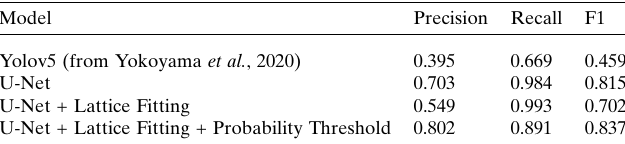
Table 3 Performance metrics of different methods on held-out sessions for hole localization from medium-magnification images. Reported metrics are aggregated by session and averaged. Definitions of true positive, false positive and false negative used for computing precision, recall, and F1 can be found in Section 3.3 and Appendix D .